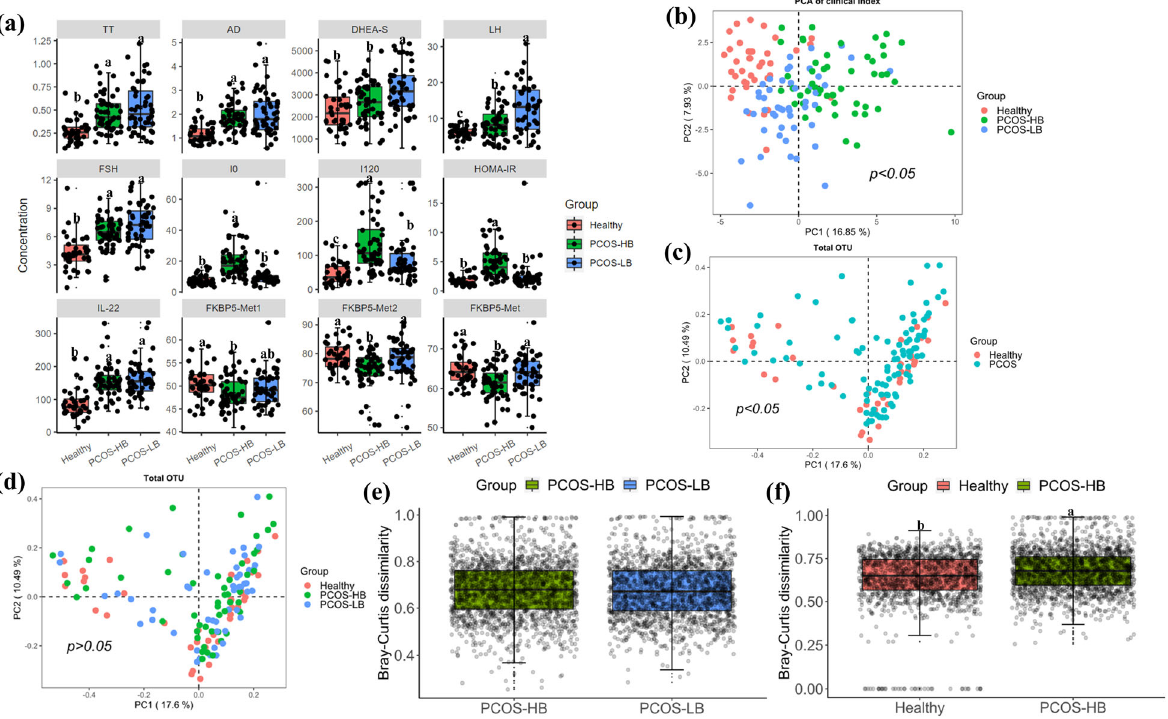
Fig. 1 Clinical and bacterial community characteristics comparison. a Differences in clinical index among healthy participants, and participants with PCOS-HB and PCOS-LB, respectively. The data are shown as the mean ± SD and error bar was used. b Differences in clinical index structures among healthy participants, and participants with PCOS-HB and PCOS-LB, respectively. c Differences in clinical index structures between healthy participants and participants with PCOS. d Differences in bacterial structures among healthy participants, and participants with PCOS-HB and PCOS-LB, respectively. e Comparison of Bray – Curtis distance between the PCOS-HB and PCOS-LB groups relative to the healthy group. f Comparison of Bray – Curtis distance between the PCOS-HB and healthy relative to the PCOS-LB group. The data are shown as the mean ± SD and error bar was used. Red, green, and blue color represent Healthy, PCOS-HB and PCOS-LB group separately. PCOS-LB, normal BMI (BMI < 24); PCOS-HB, high BMI (BMI ≥